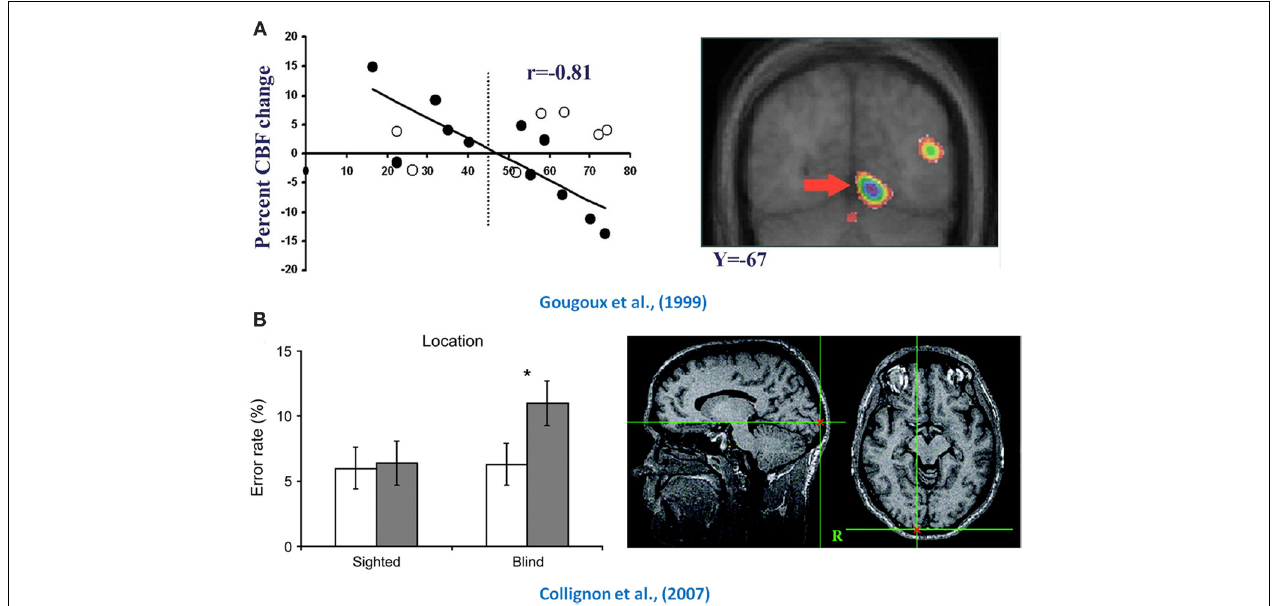
FIGURE 1 | Functional relevance of crossmodal plasticity. Illustrated here are demonstrations of the functional role played by the occipital cortex in spatial hearing tasks in early blind individuals. The top row (panel A ) depicts the finding that occipital activity in early blind individuals (black dots) was predictive of their performance in a sound localization task (Gougoux et al., 2005). The bottom row (panel B ) illustrates the effect that TMS has when